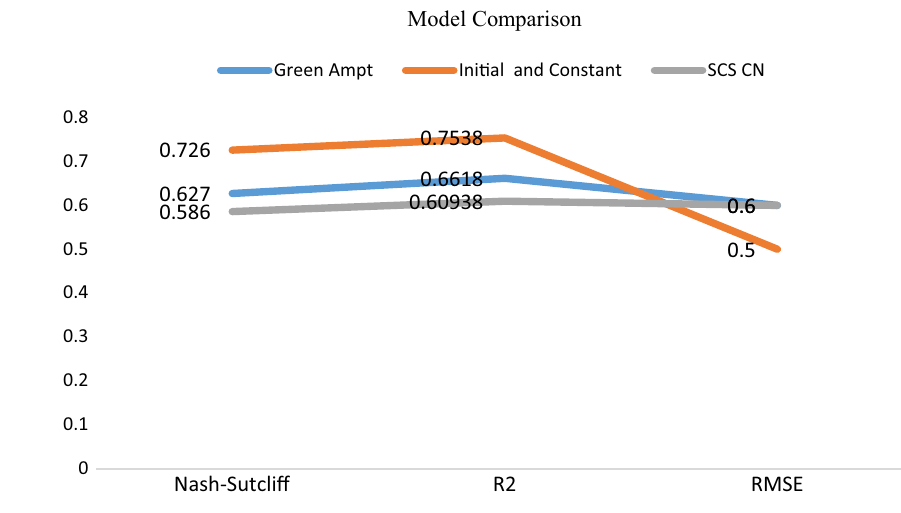
Fig. 8 Model performance